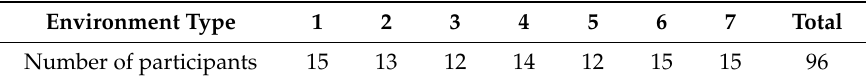
Table 2. Number of participants assigned to di ff erent forest resting